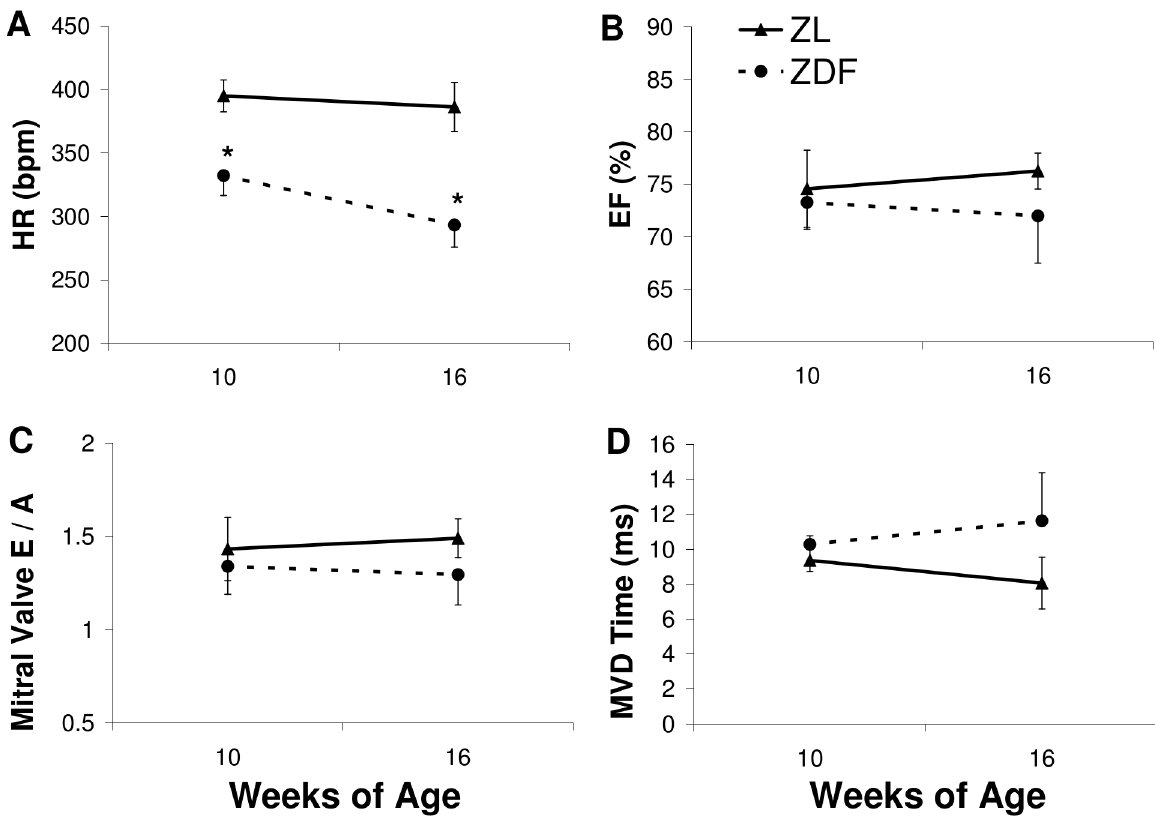
Fig 4. Assessment of systolic and diastolic function. Echocardiographic assessment of HR (A), %EF (B), mitral valve E/A (C), and MVD (D) in ZL and ZDF at 10 and 16 weeks of age. n = 4 per group. Data are mean ± SD. * p < 0.05 vs ZL at a given time point, Student ’ s t-test.